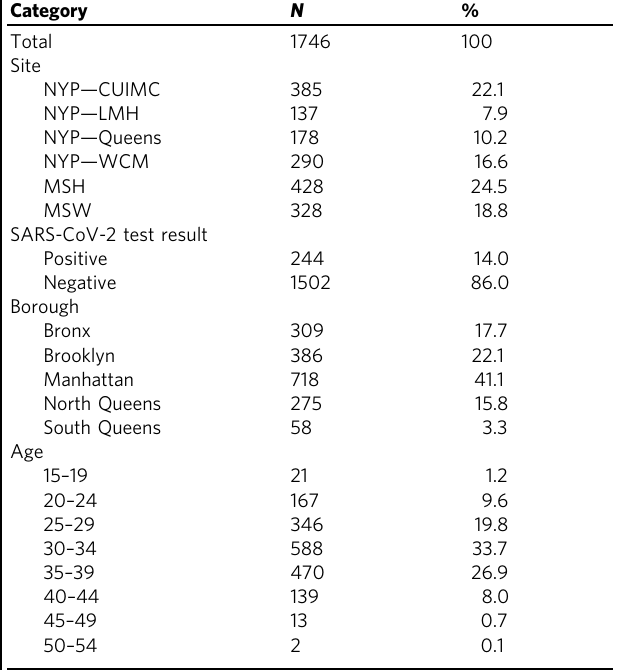
Table 1 Characteristics of the study